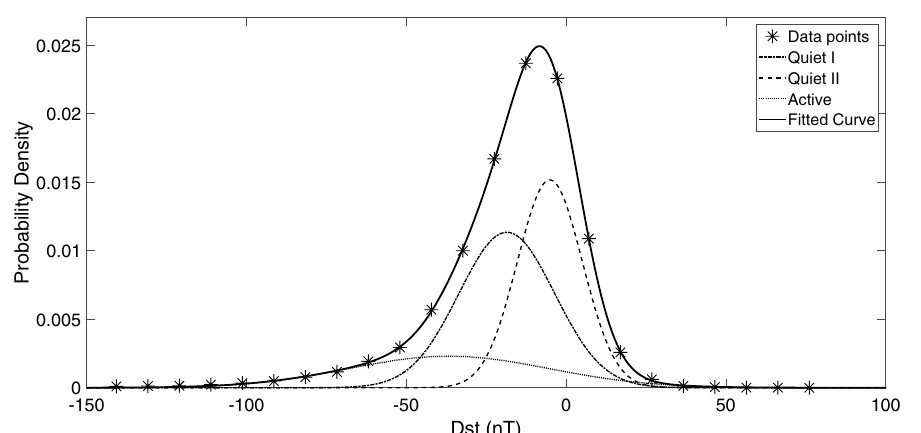
Figure 3. Probability Distribution Functions of Dst during 1981–2018.